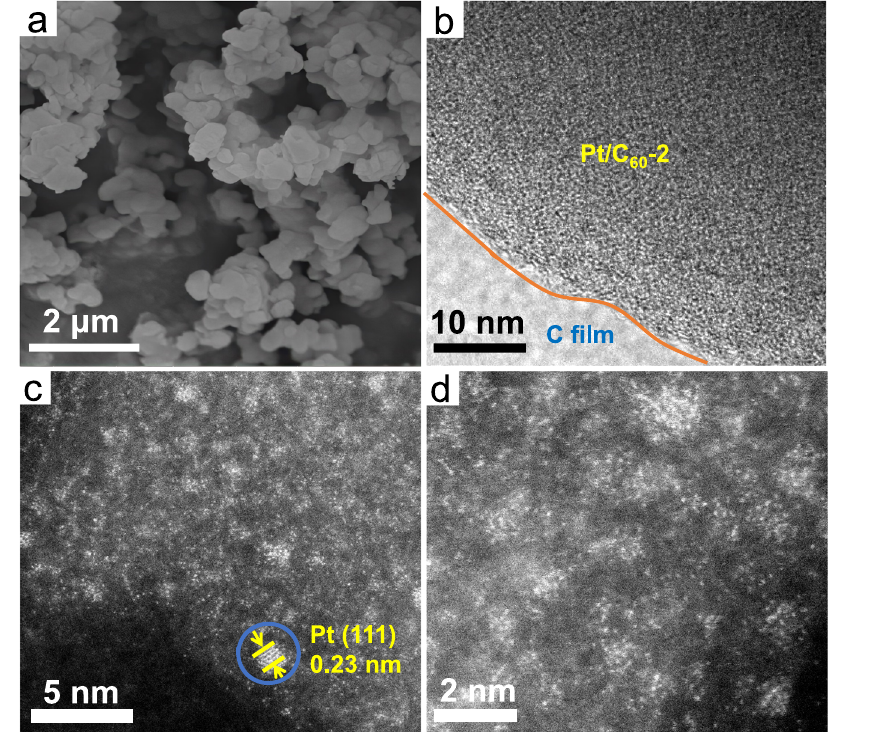
Fig. 3 | Morphological characteristics of Pt/C 60 -2. a SEM, b HRTEM, and c , d HAADF-STEM images of Pt/C 60